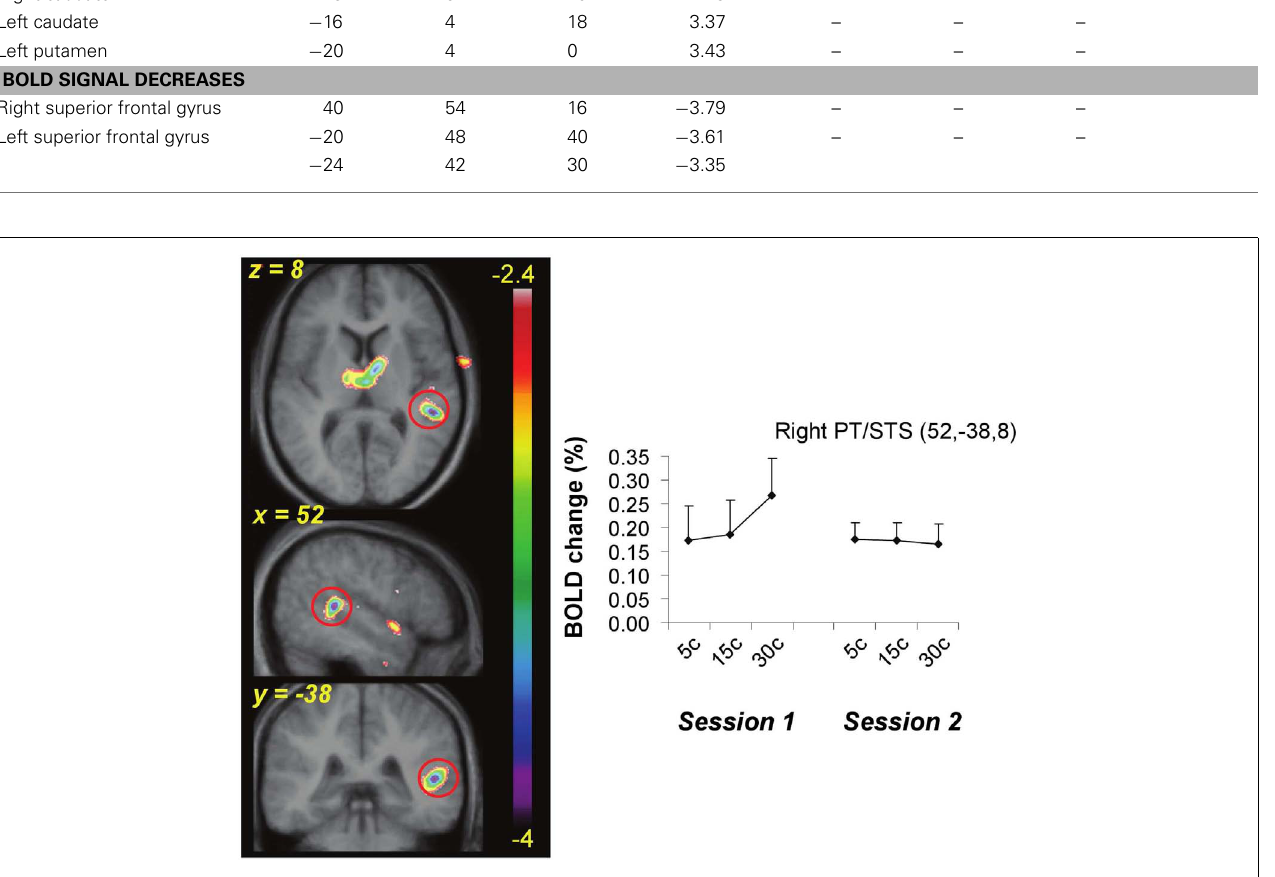
temporale and superior temporal sulcus (red circle) showed significant covariation with pitch interval size prior to training (Session 1) but a flat function after training (Session